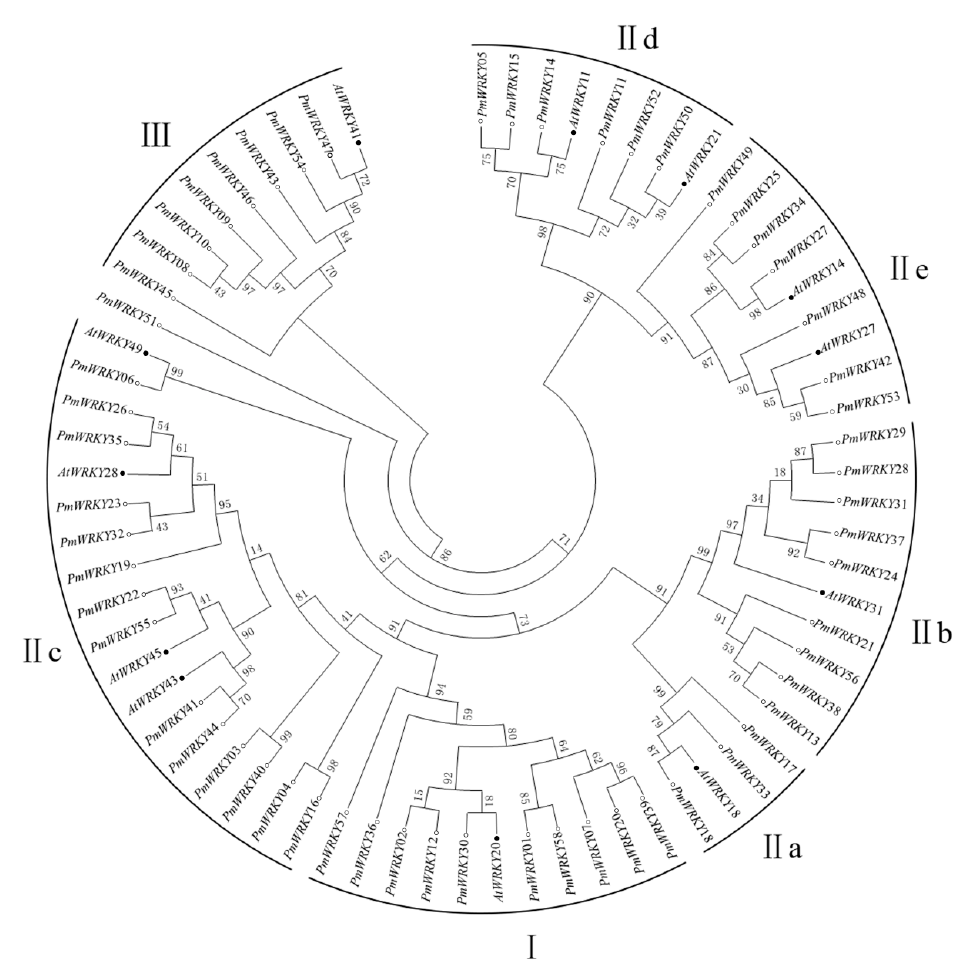
Figure 1. Tree of PmWRKYs. The unrooted phylogenetic tree of PmWRKY proteins was constructed using MEGA5.1 program by the neighbor-joining method with 1,000 bootstrap replicates. AtWRKYs were used as references to categorise PmWRKYs. The tree was divided into seven phylogenetic subgroups, designated as I, IIa-e, and III. The black solid points denote AtWRKYs, and the hollow points denote PmWRKYs.